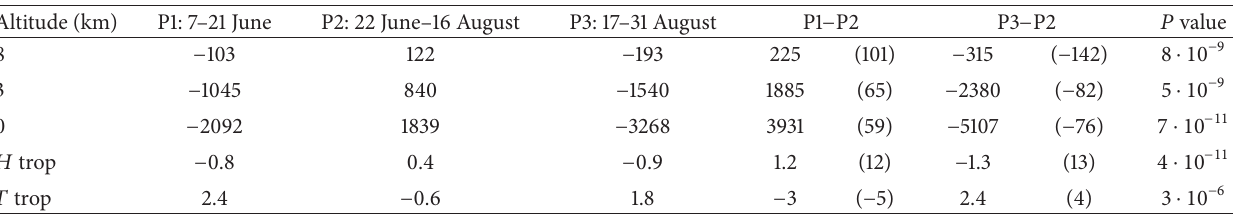
Table 3: Water vapor anomalies in the surface layer (0km) and at the altitudes 3km and 8 km (ppm) as well as the anomalies of tropopause height ( 𝐻 trop (km)) and temperature ( 𝑇 trop ( ∘ C)) before (P1), during (P2), and after (P3) blocking events of the summer 2010 and their differences obtained using upper air data (Table 1). The percentage differences in relation to the local yearly mean values are shown in parentheses. Last column represent a probability ( 𝑃 value) that the medians of three groups of the anomalies are from the same population, calculated using the Kruskal-Wallis